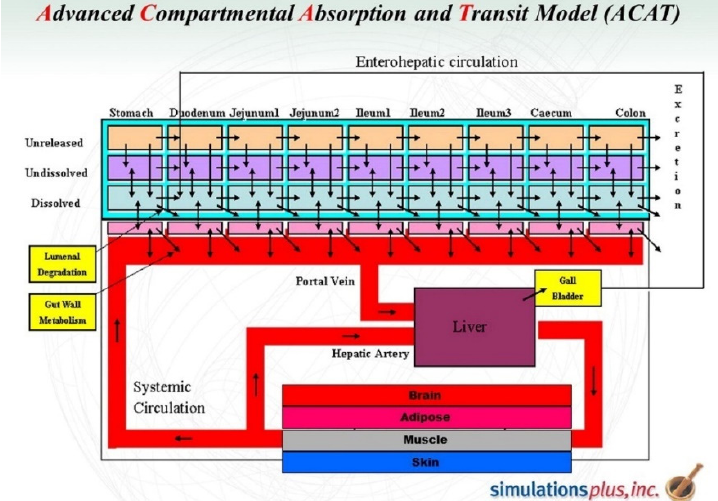
Figure 5. GastroPlus™ advanced compartmental absorption and transit model (ACAT™). Adapted from [38].